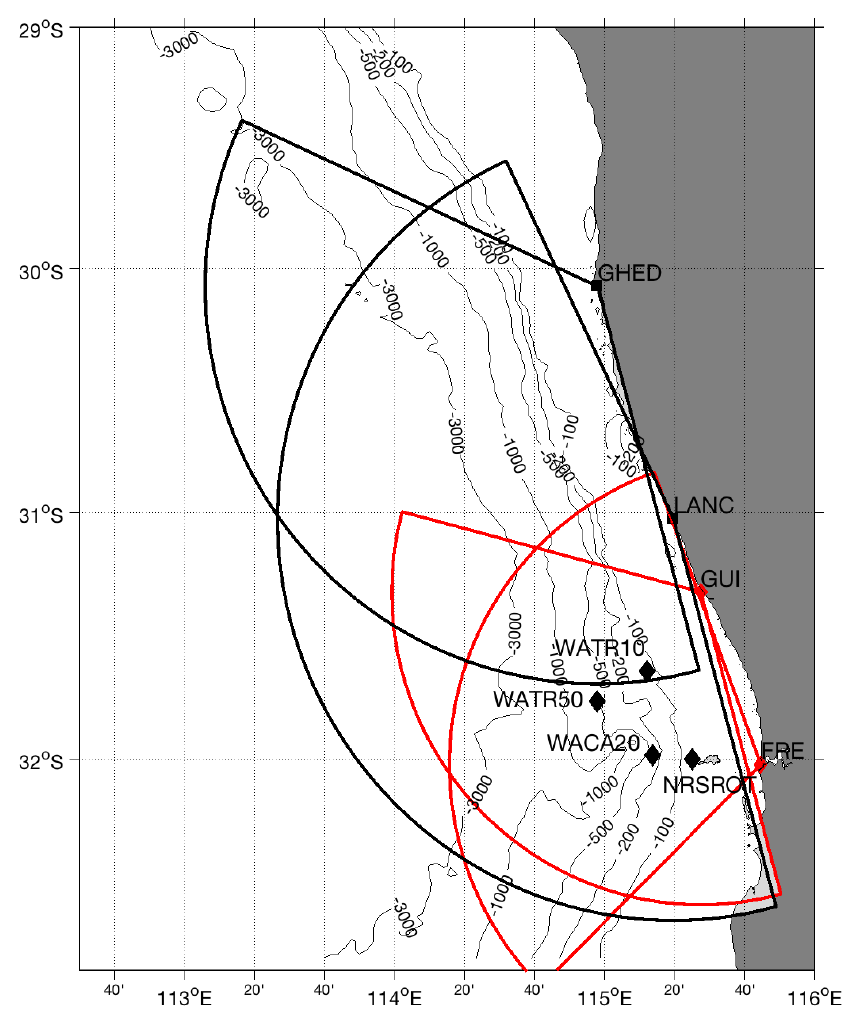
Figure 1. Coverage of the high-frequency radar (HFR) systems deployed along the Western Australia (WA) coast, with the dominant bathymetric features. Red (black) markers are used for the WEllen RAdar WERA (SeaSonde) Fremantle (FRE) and Guilderton (GUI) stations (Green Head (GHED) and Lancelin (LANC)); red (black) areas show the typical coverage of each HFR station. Mooring locations are marked as black diamonds inside the HFR footprints. NRSROT, WATR50, WATR10 and WACA20 stand for Rottnest Reference Station, WA Two Rocks 490 m, WA Two Rocks 103 m, and WA Perth Canyon 200 m moorings, respectively.